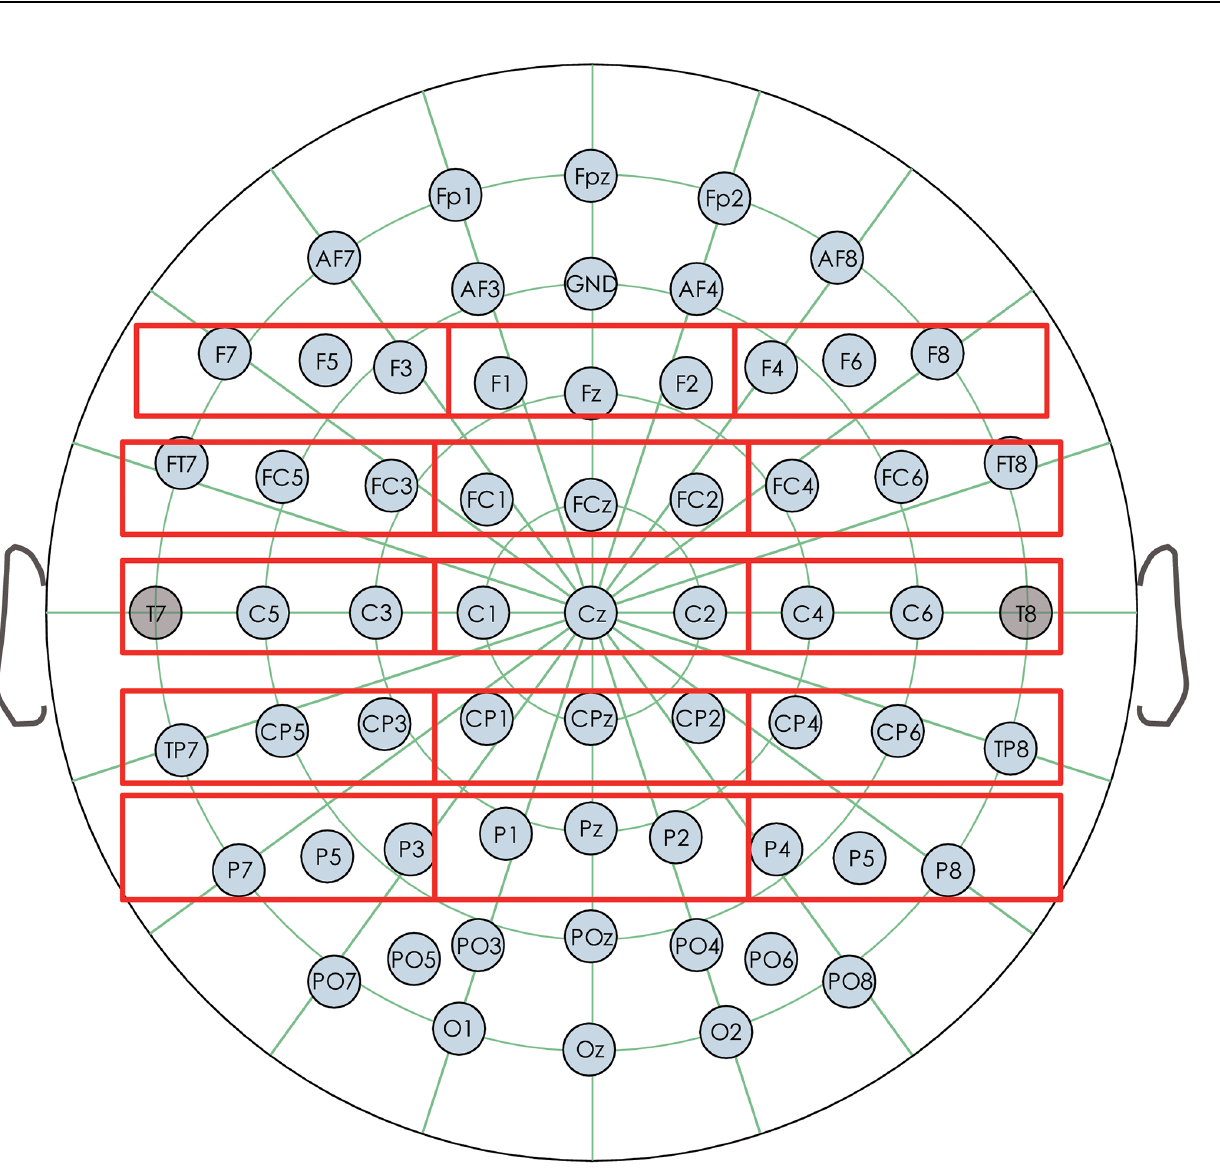
Fig 1. The electrodes used in the present